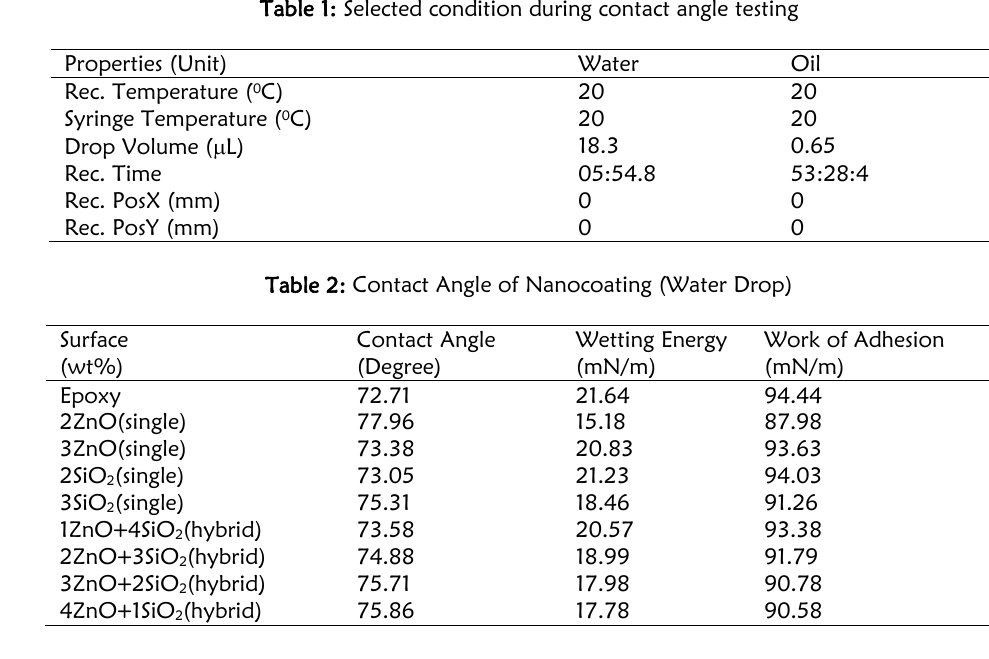
Table 3: Contact Angle of Nanocoating (Oil Drop)